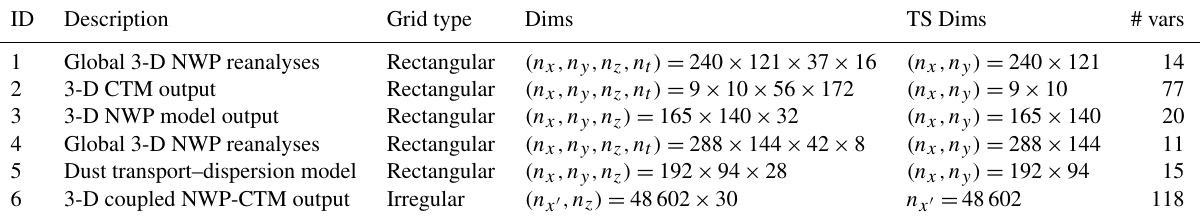
Table 1. Summary of the data sets used in this study. Abbreviations: ID – index, NWP – numerical weather prediction, CTM – chemistry- transport model, Dims – dimensions of the variable, TS Dims – dimensions of the thin slice, # vars – number of variables per data set. The dimension sizes are indicated as n x – length of the east–west dimension, n y – length of the north–south dimension, n z – length of the vertical dimension, n t – length of the time dimension and n x (cid:48) – length of the generalized horizontal coordinate dimension (used for the unstructured grid in last data set